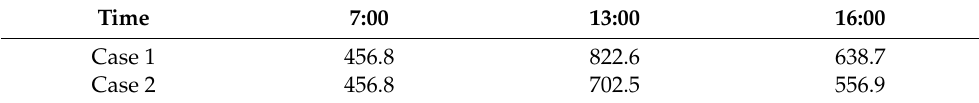
Table 14. System operating costs under different cases (thousand